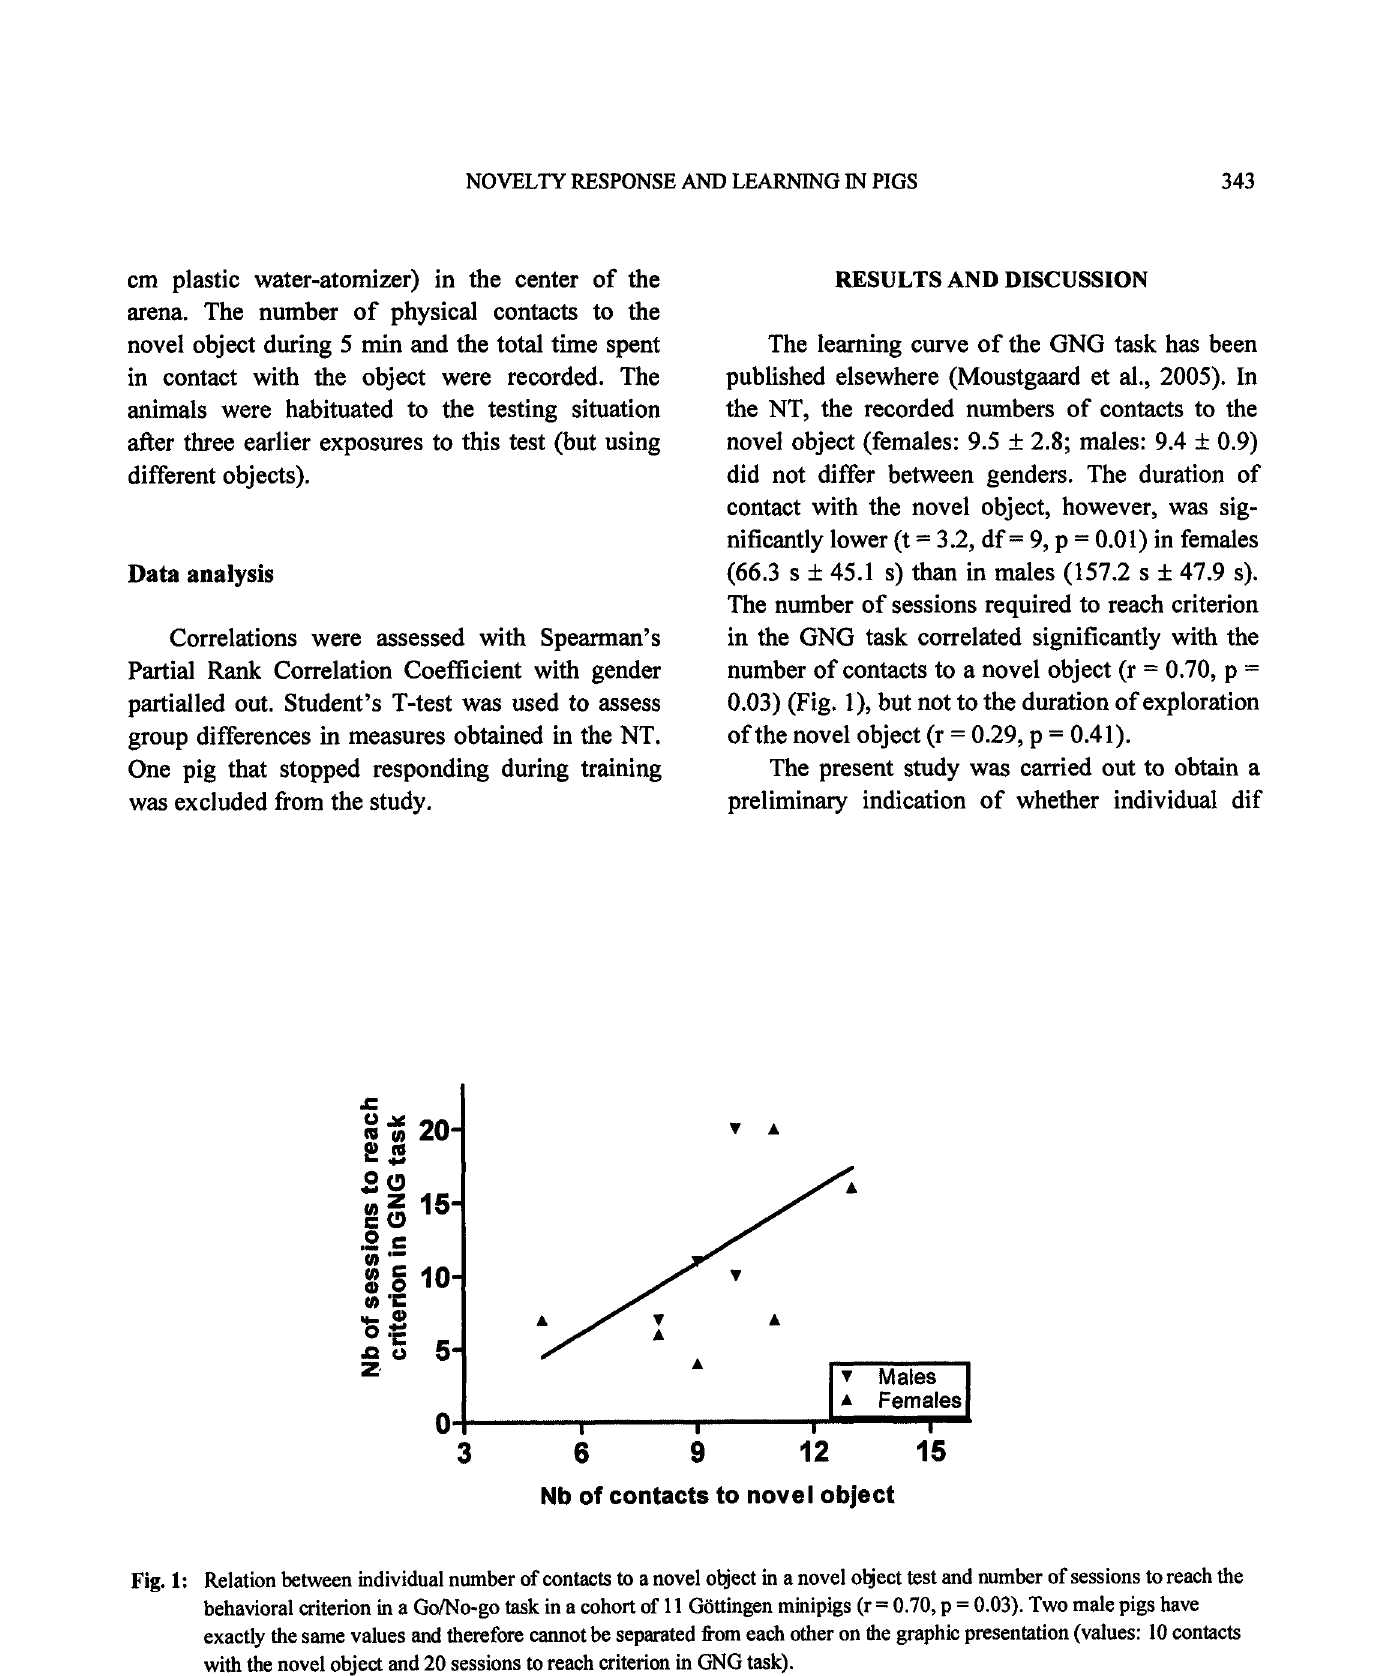
Fig. 1: Relation between individual number of contacts to a novel olect in a novel oect test and number of sessions to reach the behavioral criterion in a Go/No-go task in a cohort of 11 G6ttingen minipigs (r 0.70, p 0.03). Two male pigs have exactly the same values and therefore cannot be separated from each other on the graphic presentation (values: 10 contacts with the novel object and 20 sessions to reach criterion in GNG